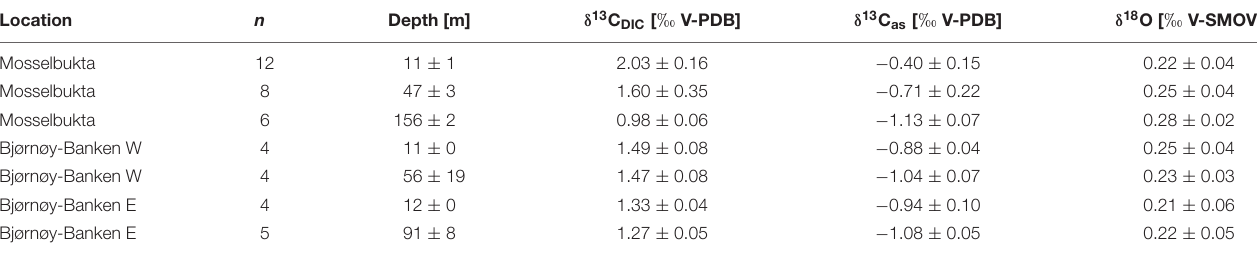
TABLE 4 | Stable isotope and DIC values in Mosselbukta and at Bjørnøy-Banken (W and E of the Polar Front) for surface waters and for bottom waters, averaged over the available CTD casts (bottom water stations complemented with water samples taken by JAGO; total number of considered samples per depth indicated in the second